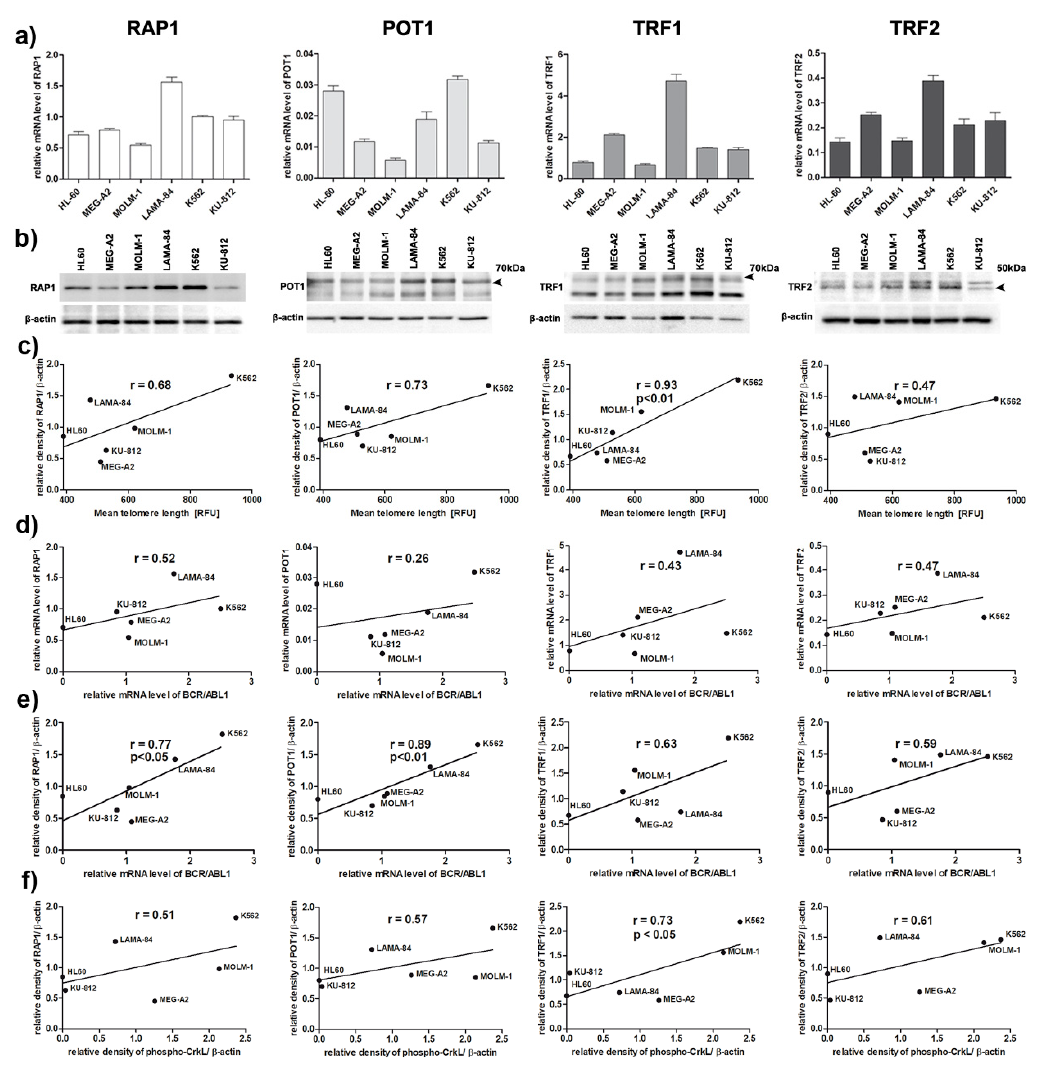
Figure 4. Role of selected shelterin proteins in telomere maintenance in BCR / ABL1 -positive cell lines. ( a ) RT-qPCR analysis of shelterin genes. Relative quantification of each gene expression level was normalized according to the gene expression β 2M and GUSB ; ( b ) Western blotting analysis of RAP1, POT1, TRF1 and TRF2. β -Actin served as a loading control; ( c – f ) Pearson’s (r) correlations of: ( c ) mean telomere length and shelterin proteins level; ( d ) BCR / ABL1 expression and RAP1 , POT1 , TRF1 , TRF2 genes expression; ( e ) BCR / ABL1 expression and shelterin proteins level; ( f ) activity of BCR / ABL1 kinase and protein level of RAP1, POT1, TRF1, TRF2.